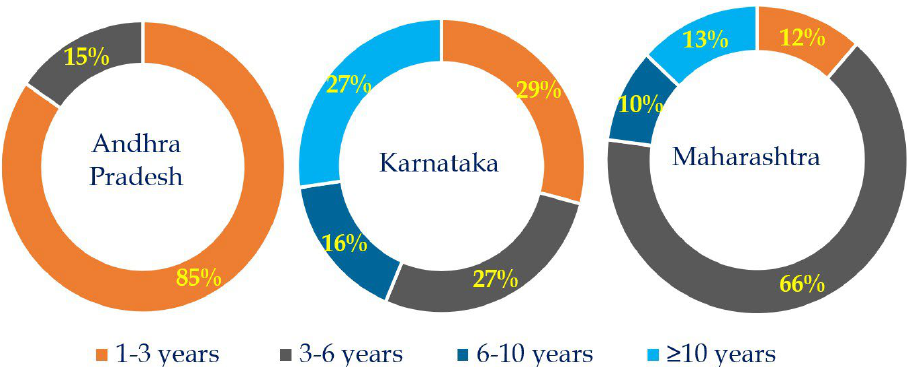
Figure 2. Experience of practicing natural farming by the sample farmers. Intercropping is a major recommended practice in Natural Farming as it reduces soil stress by reducing the mining of only specific nutrients from the soil, as in the case of a solo/mono crop. In some cases, intercrops/mixed crops complement each other in terms of nutrient cycling. Nonetheless, despite its recommendation, only 26%, 45%, and 17% of NF farmers in Andhra Pradesh, Karnataka, and Maharashtra, respectively, practice inter- /mixed crops. (Figure 3). Figure 3. Percentage of sample farmers following mixed cropping or intercropping in natural farm- ing. The low percentage of inter-/mixed cropping is due to the fact that paddy is the major crop in the study area and is preferably cultivated as a single crop. Karnataka (45%) had the highest rate of inter/mixed cropping among the study states. It was observed that al- most the same proportion of farmers in Andhra Pradesh and Maharashtra practiced in- ter/mixed cropping in both NF and non- NF. However, in Karnataka, only 10% of non-NF farmers practiced inter/mixed cropping. In Andhra Pradesh, a solid form of jeevamritha called as ghanajeevamritha was used by the farmers. The farmers applied ghanajeevamritha (0.5–1 t ha − 1 ) by broadcasting before sowing in the field. Beejamritha for seed treatment was used depending on the crop as well. There was no fixed quantity of jeevamritha used in the field. Farmers in Karnataka were found to use higher quantities of jeevamritha than other state farmers. It was as high as 3000 liters per acre in Paddy. It was also found that farmers who used Farm Yard Manure (FYM) in the field applied lower quantities of jeevamritha. Although, NF practice does not advocate the use of FYM, it was found that NF farmers used FYM in the field before sow- ing. In Andhra Pradesh, 52% of farmers use d FYM in all crops, while 36% did not use it at 26%